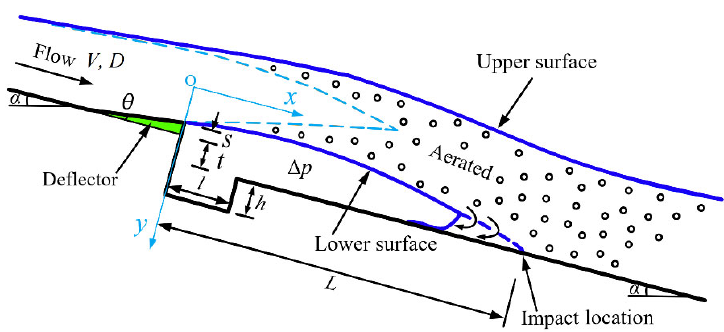
Figure 3. Chute aerator configuration with air-cavity formation and flow pattern.